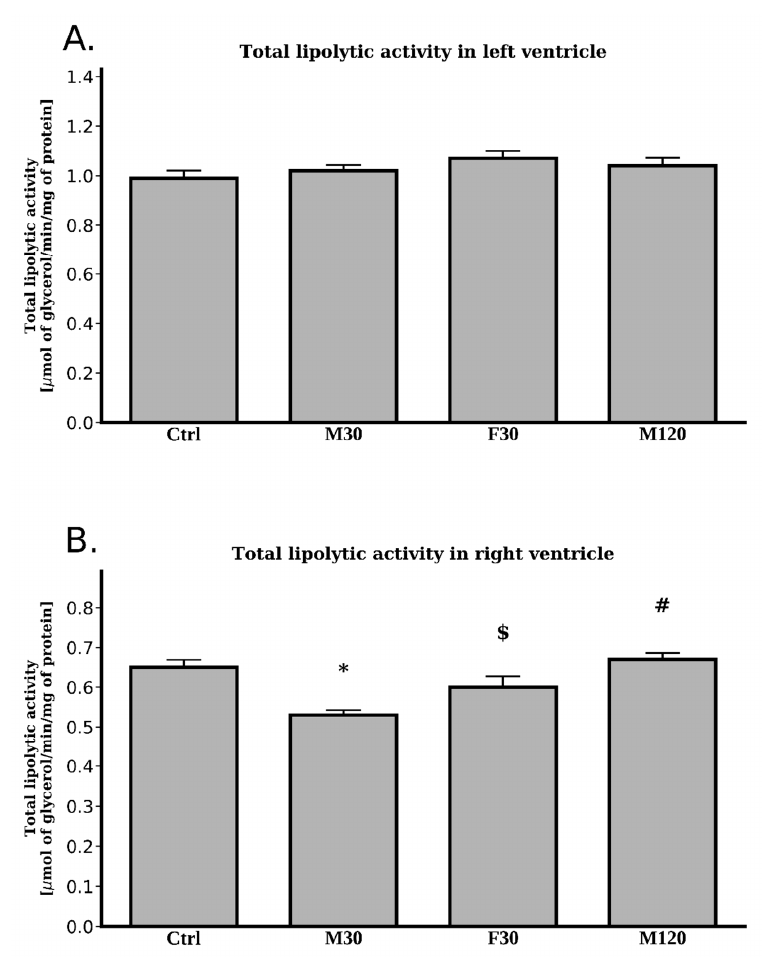
Figure 4. Effects of treadmill running on the total lipolytic activity in left ventricle ( A ), right ventricle ( B ). Data are expressed as mean ± SEM. * p < 0.05 difference vs. control (Ctrl); # p < 0.05 difference M120 vs. M30; $ p < 0.05 difference F30 vs. M30.